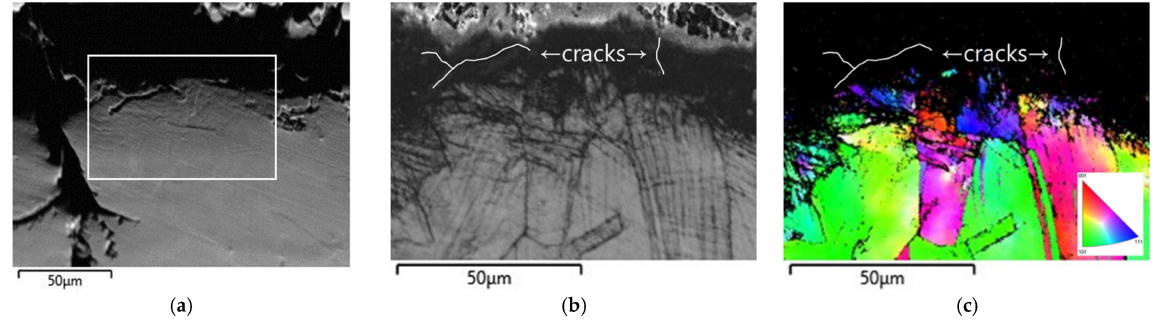
Figure 17. EBSD results of the cracking area of laser-peened 304L base metal after SCC test: ( a ) SEM image, ( b ) band contrast, ( c ) inverse pole figure (IPF) coloring.